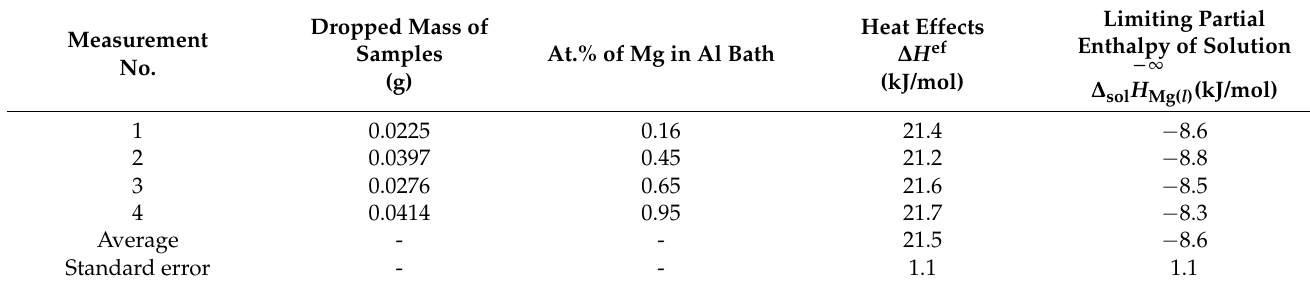
Table 3. Values of the limiting partial enthalpy of the solution of liquid Mg ∆ sol H pressure p = 0.1 MPa; calibration constant K = 0.000003207 kJ/ µ Vs; enthalpy of the pure Mg ∆ H T 298 → T 1033 temperature of the Al bath T M = 1033 K; and drop temperature T D = 298